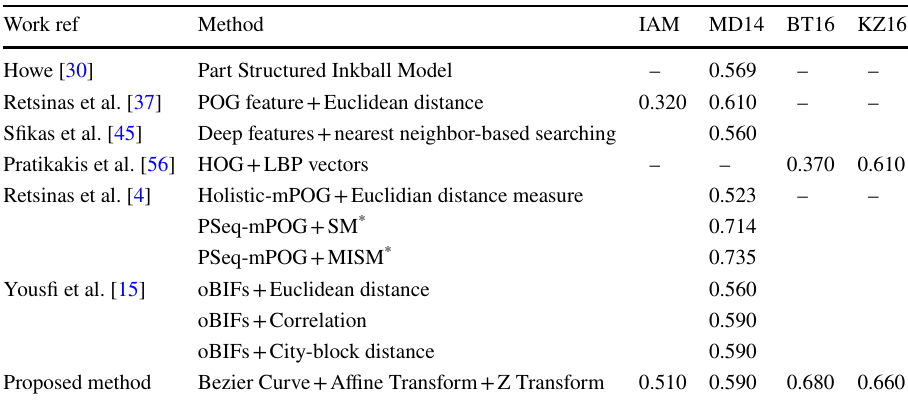
Table 3 Comparison of the proposed method with state- of-the-art methods in terms of P@5